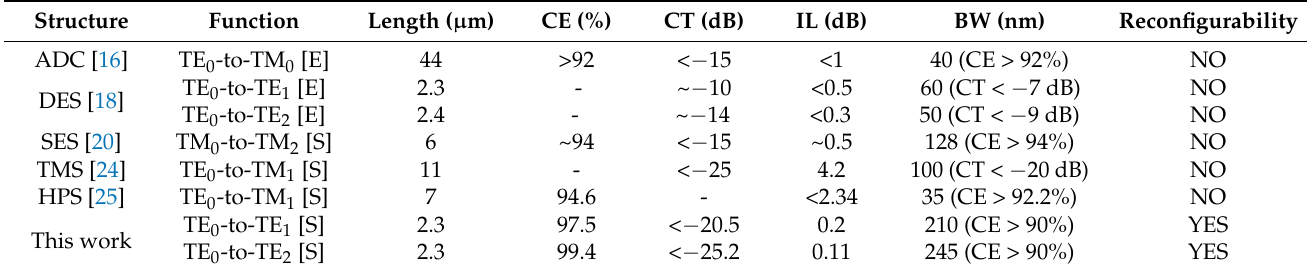
Table 1. Comparison of the proposed mode converter with typical mode converters reported in the literature.